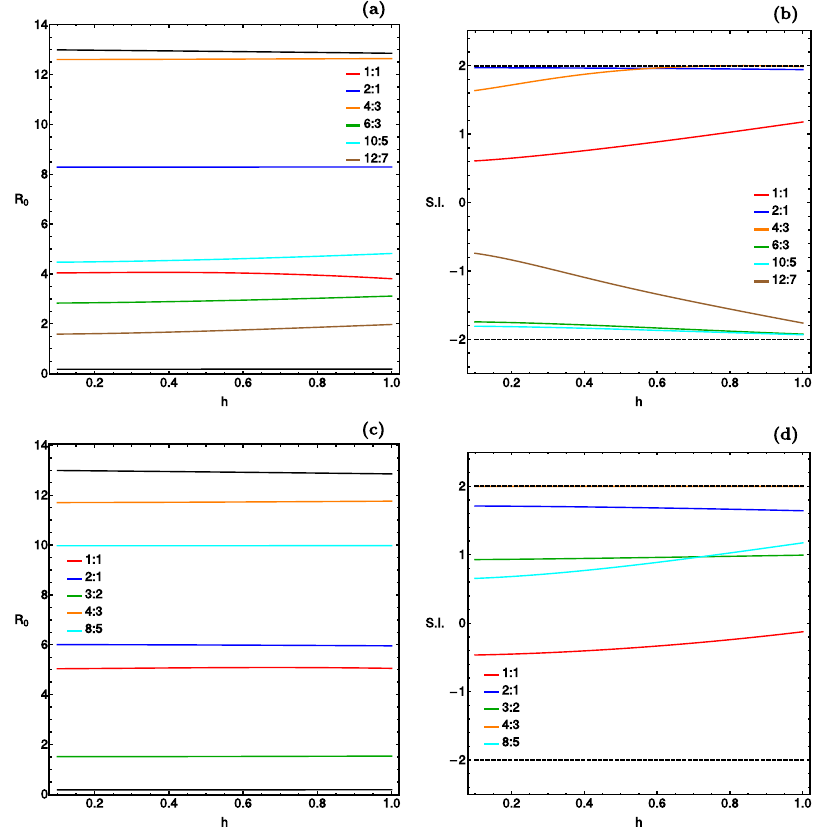
Fig. 6. Evolution of the R coordinate of periodic orbits as a function of the scale height of the disk, h , for the PH models (panel a) and OH models (panel c), and the evolution of the stability index S.I. as a function of h for the PH models (panel b) and OH models (panel